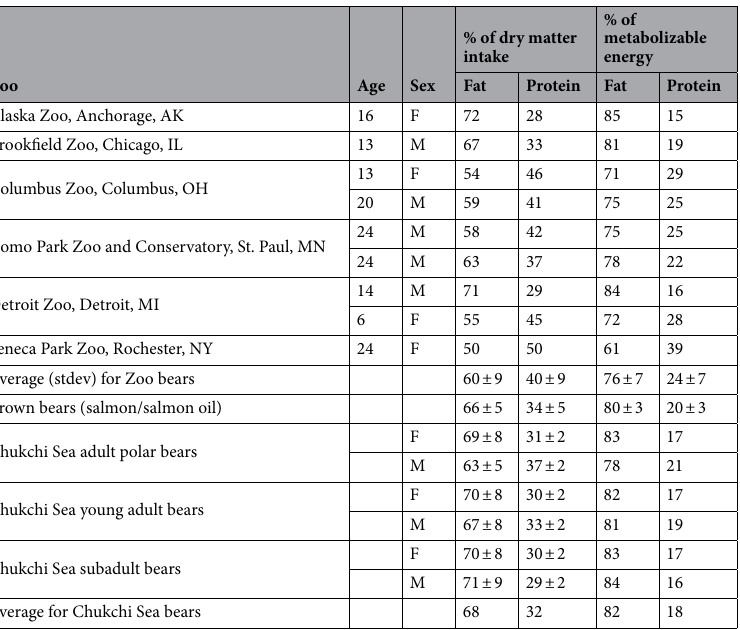
Table 2. Fat and protein intake of 9 zoo polar bears and 5 captive brown bears fed ad libitum options of meat and fat (lard or salmon oil) and free-ranging polar bears in the Chukchi (n = 229) consuming diets of marine mammal prey. Zoo polar bears were provided lean meat and lard. Brown bears were provided salmon and salmon oil 11 . Standard deviations were calculated for the dry matter intake of fat and protein of Chukchi Sea polar bears using standard deviations of individual dietary components in Table 1 with respective proportional protein and fat content of prey tissues.